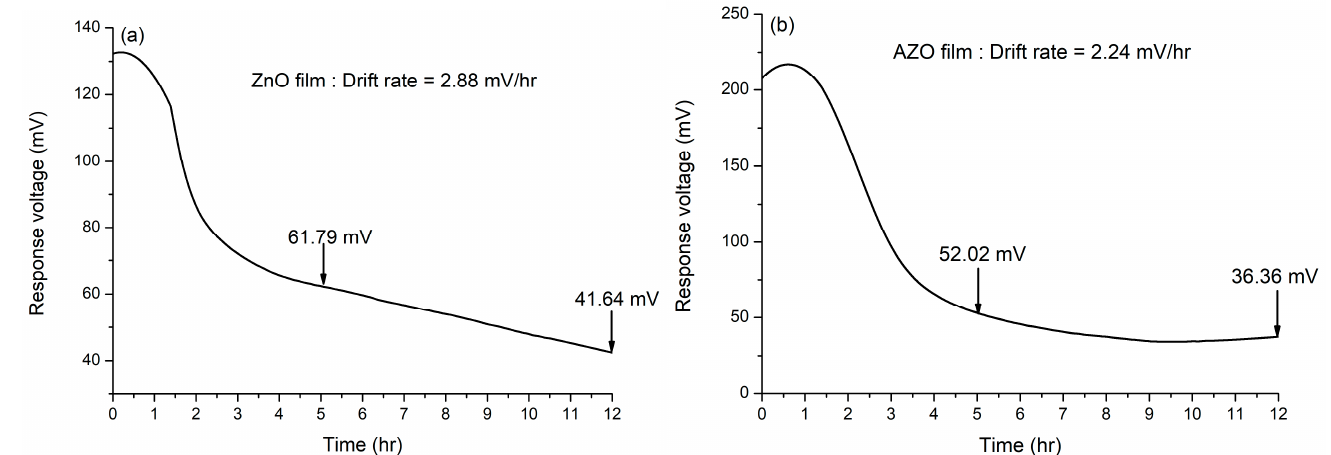
Figure 7. The drift of the pH sensors based on ( a ) ZnO and ( b ) AZO films. Table 5. The comparisons of the drift effect based on pH sensors with different structures.